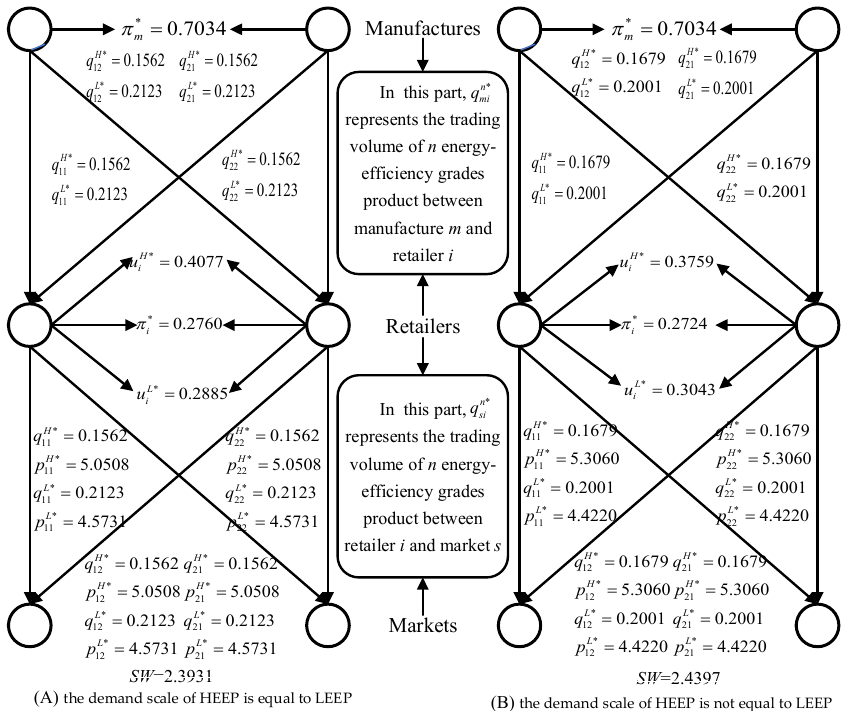
Figure 4. The results of SCNE in different market scales.